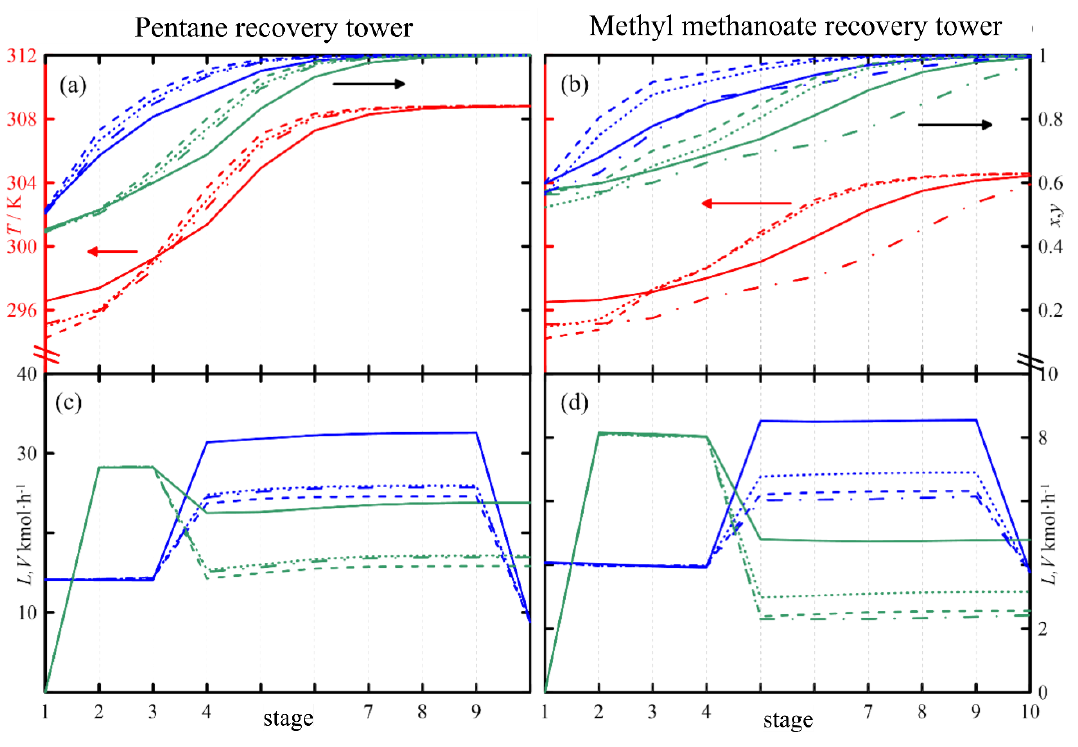
Figure 13. Profiles in the recovery columns of pentane (C-1) and methyl methanoate (C-2). ( a , b ) ( ) temperature; ( ) liquid composition ( ) vapor composition. ( c , d ) ( ); liquid flow, L ( ) vapor flow, V . ( — ) P1, ( – – – ) P2, ( – – – ) P3, (· · · ·) P4.